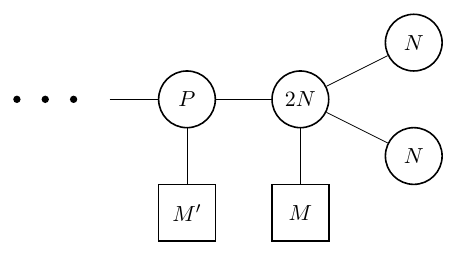
Figure 56 . A D -type quiver gauge theory with unitary gauge groups.